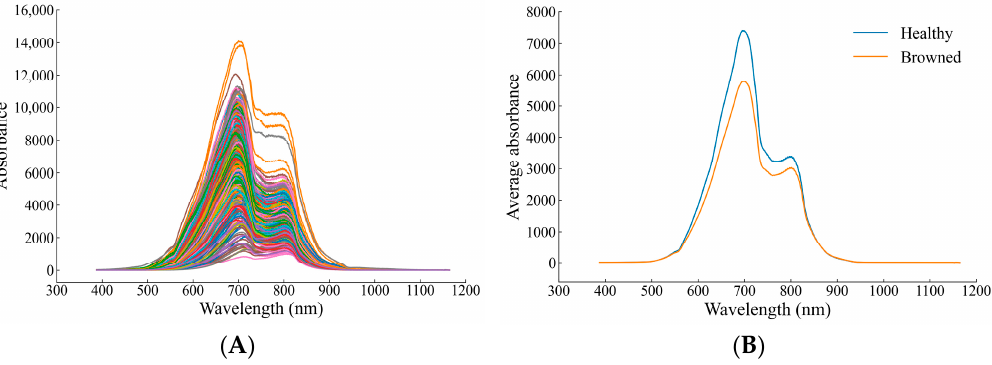
Figure 5. Vis-NIR spectra of healthy and browned pears: ( A ) raw spectra; ( B ) average spectra.